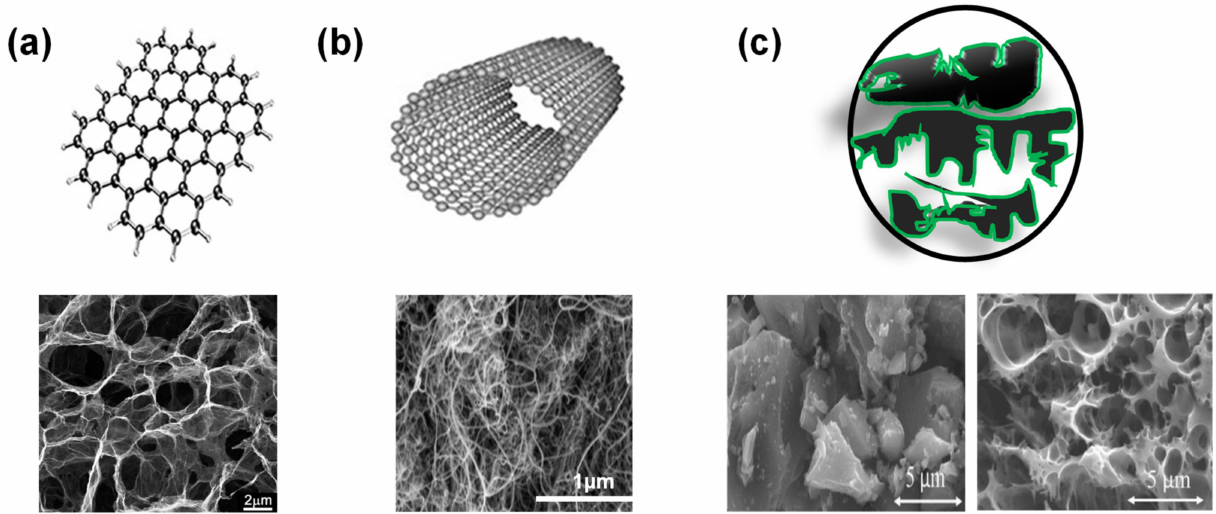
Figure 5. Structures and SEM micrographs of ( a ) graphene, ( b ) CNT, and ( c ) activated carbon: obtained from coconut shell and chitosan biomasses, reproduced with permission from Refs.